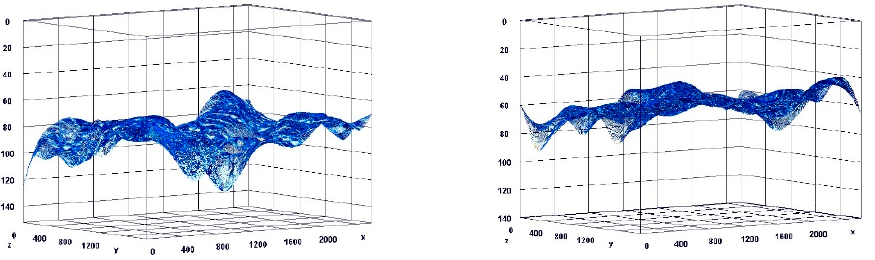
Figure 16. Visualization of the differences in collagen concentration before and after treatment (Tri- chrome).